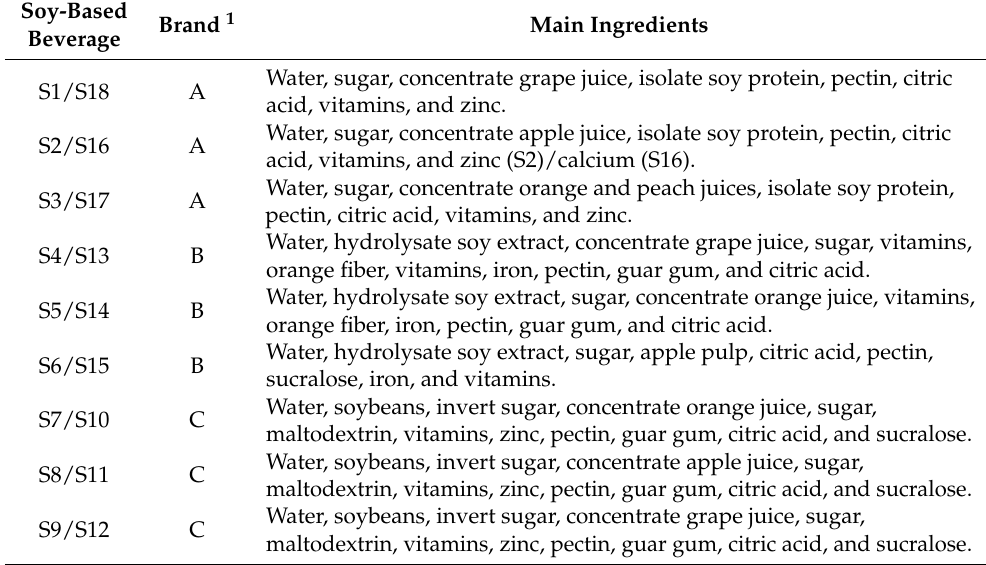
Table 1. Soy-based beverages—main ingredients.